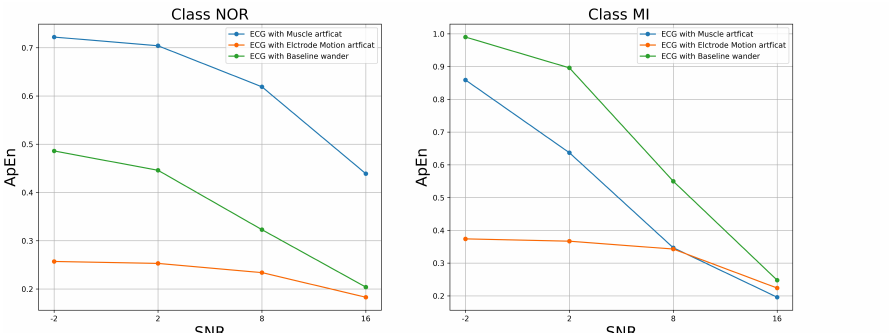
Figure 7. ApEn versus SNR of the ECG-filtered signal with added noise.